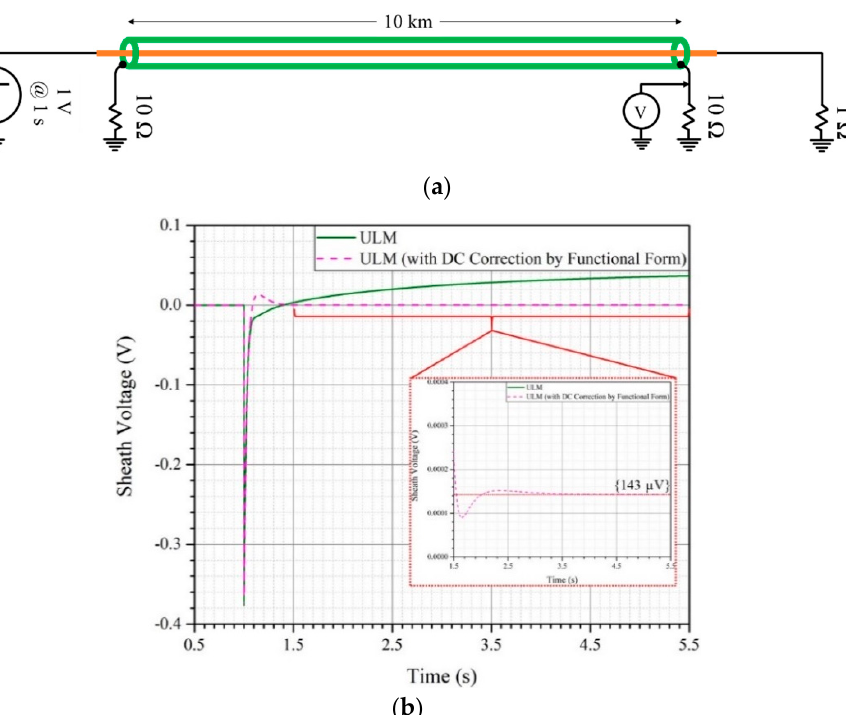
Figure 7. ( a ) A unit step voltage is applied on the sending end, while the receiving end is grounded via a low resistance ground electrode. Sheath voltage is measured at the receiving end. ( b ) Comparison of measured sheath voltage with and without the DC correction of